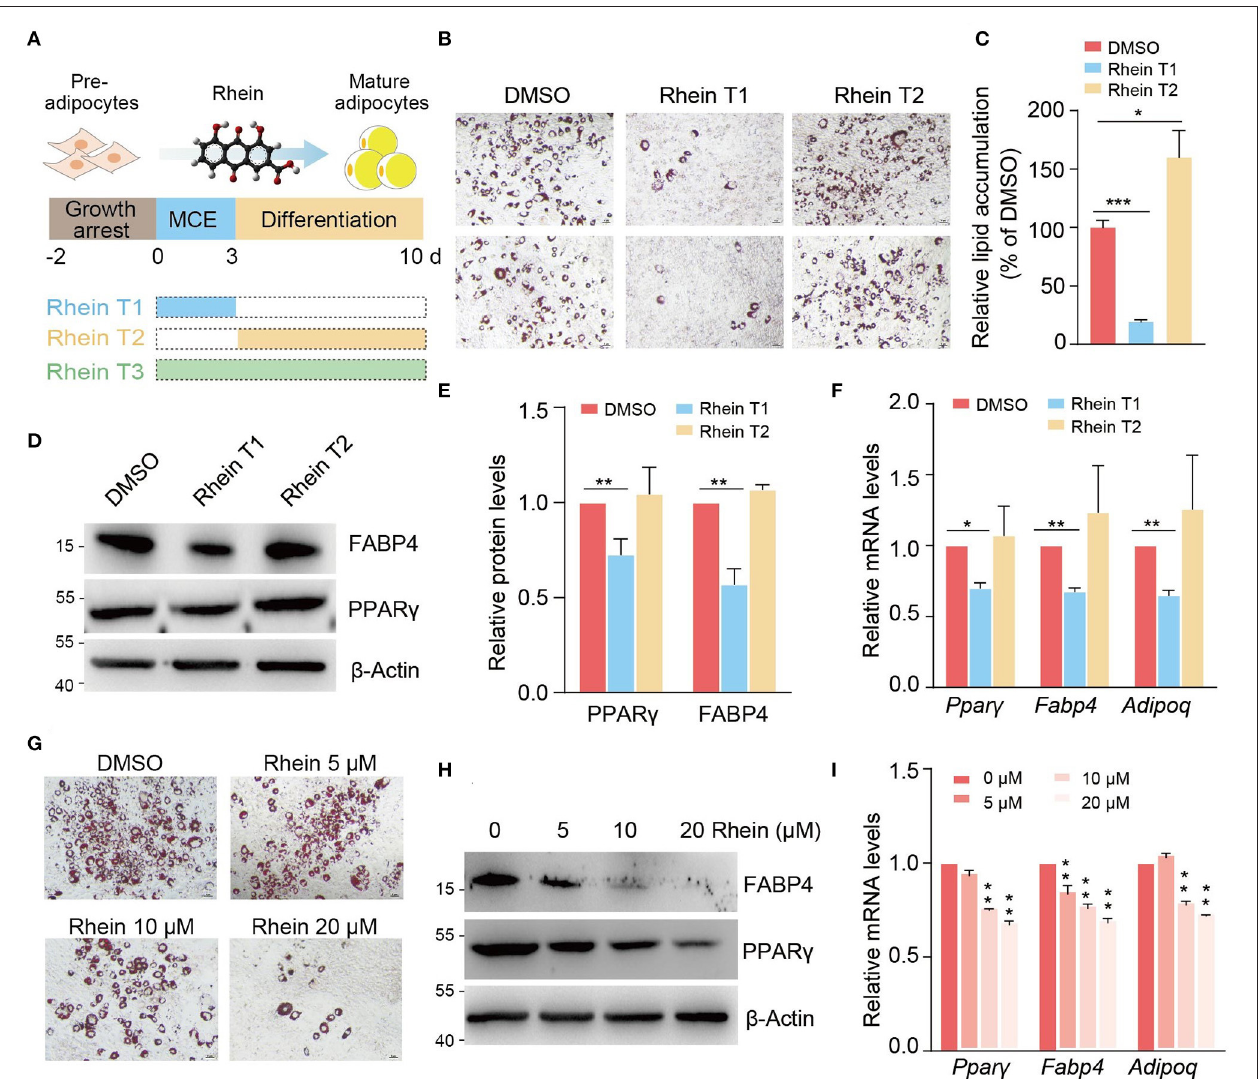
FIGURE 1 | Rhein suppresses adipogenesis at specific stage in a dose-dependent manner. (A) Schematic representation of rhein treatment at the different stages during adipocyte differentiation. (B) The adipogenic phenotypes of 3T3-L1 cells treated with rhein at the indicated stages. Cells cultured with dimethyl sulfoxide (DMSO) were served as a negative control. Lipid accumulation was assessed by using Oil Red O staining; scale bars, 5 µ m. (C) Quantification of lipid accumulation in (B) . Error bars, mean ± SEM; n = 8 biological replicates; * p < 0.05, *** p < 0.001. (D) Western blotting of the adipogenic markers. Cells were treated with DMSO or rhein before being collected for analysis. For all the western blots in this study, molecular weight markers (kDa) are indicated on the left side. (E) Quantification of the protein levels shown in (D) . Error bars, mean ± SEM; n = 3 biological replicates; ** p < 0.01. (F) Relative messenger RNA (mRNA) levels of adipogenesis markers upon DMSO or rhein treatment. Error bars, mean ± SEM; n = 4 biological replicates; * p < 0.05, ** p < 0.01. (G) The adipogenic phenotypes of 3T3-L1 cells treated with rhein at indicated concentrations. Cells cultured with DMSO were served as a negative control. Lipid accumulation was assessed by using Oil Red O staining; scale bars, 5 µ m. (H) Western blotting of adipogenic marker proteins in cells cultured with MDI medium in the presence of various concentrations of rhein at the mitotic clonal expansion (MCE) stage. (I) Effect of rhein treatment with various concentrations on mRNA levels of adipogenesis markers. Error bars, mean ± SEM; n = 3 biological replicates; ** p <